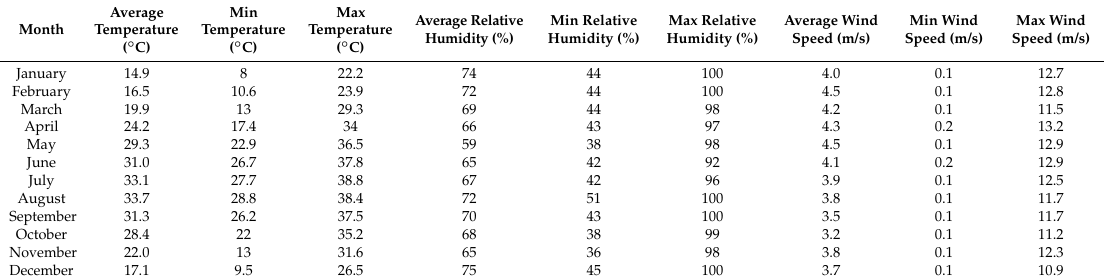
Table 1. Monthly average of weather condition in Bushehr, Iran (2000 – 2016) cited from Iran Meteorological Organization.